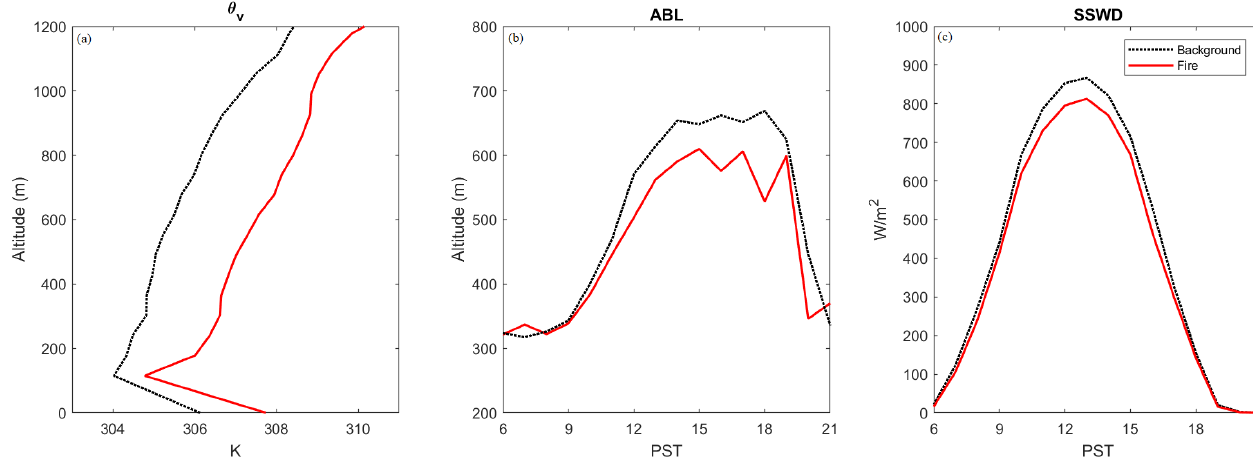
Figure 9. Averaged virtual potential temperature ( θ v ) profile between 13:00 and 15:00PST (a) , diurnal profile for daytime ABL height (b) , and diurnal SSWD profile (c) at Visalia during wildfire days (red) and background periods (black) from 2016 to